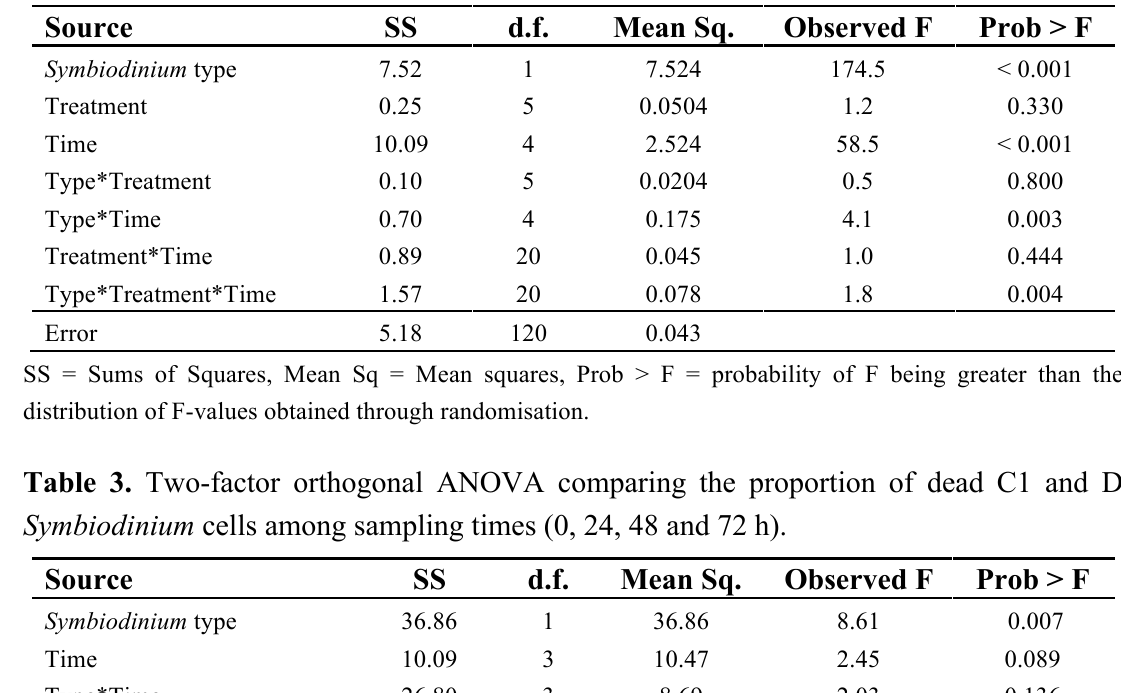
Table 2. Three-factor orthogonal ANOVA comparing the proportion of A. tenuis larvae infected with Symbiodinium cells between symbiont types (C1 and D), among cell surface treatments (two enzymes, three lectins and unmodified controls) and sampling times (12, 24, 48, 72 and 96 h).